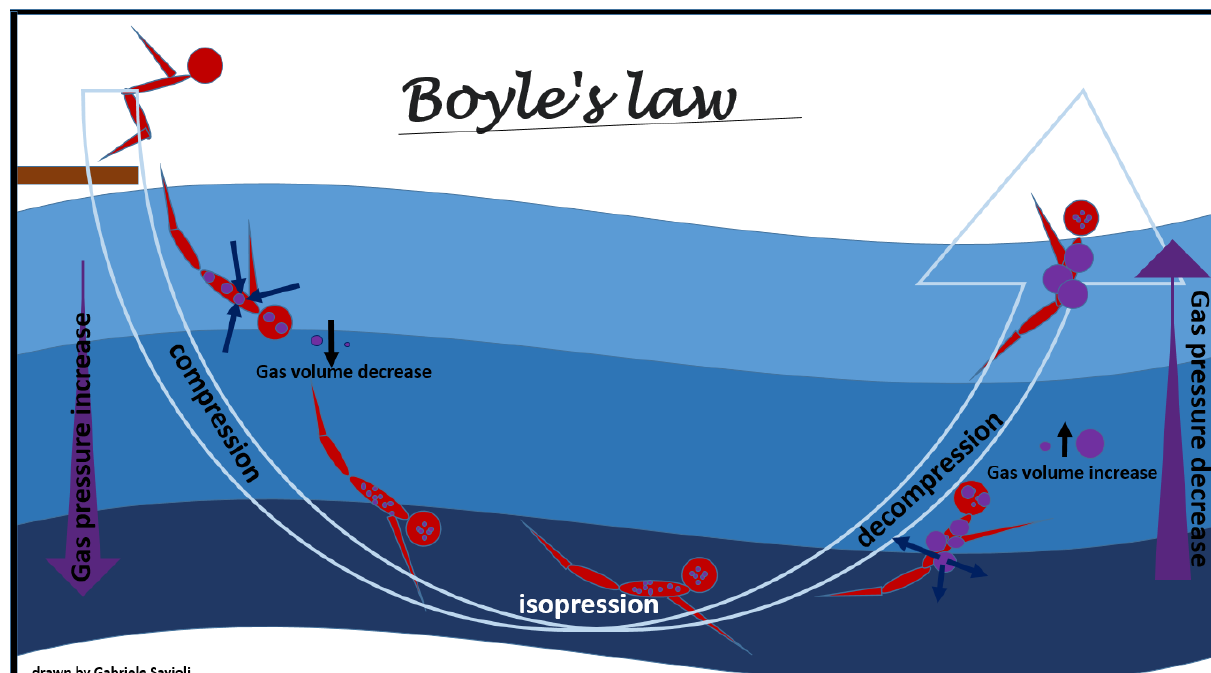
Figure 3. Boyle’s